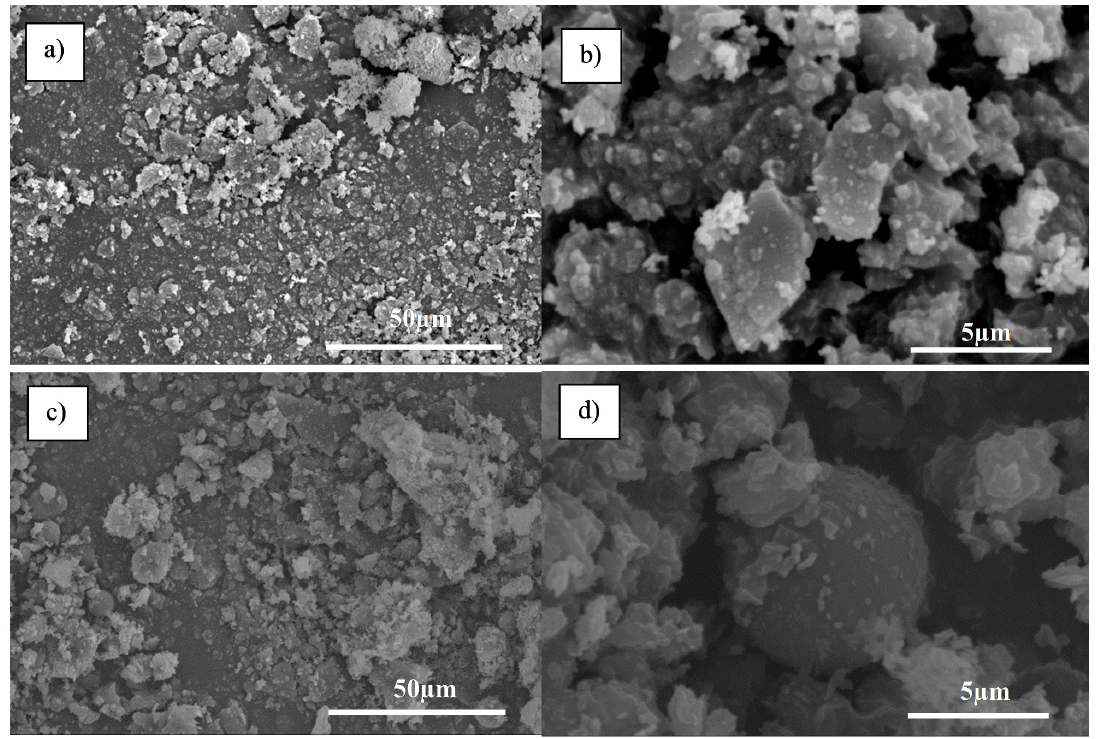
Figure 4. SEM images of calcined clays. ( a ) and ( b ): Rotary kiln calcined clay. ( c ) and ( d ): Flash calcined clay.